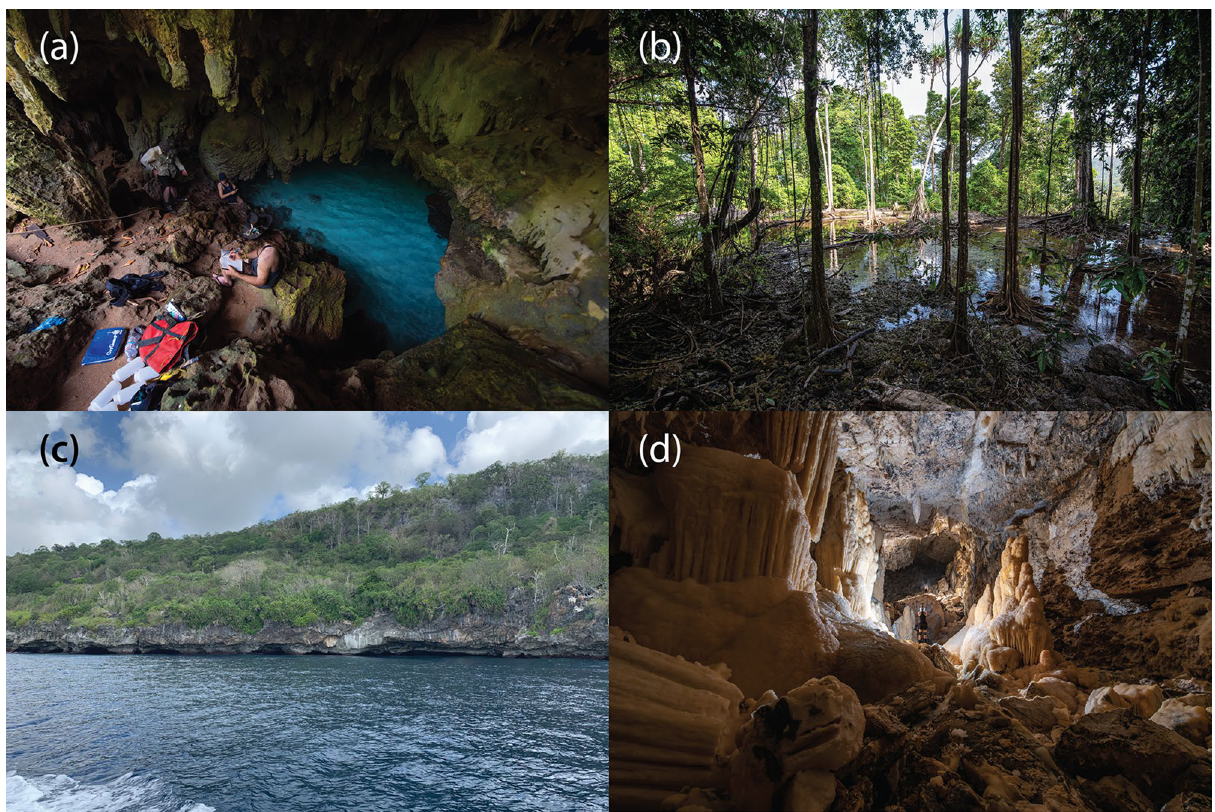
Figure 2. Imagery from eDNA sampling localities across Christmas Island. ( a ) Water and sediment sampling in The Grotto cave site. ( b ) The Dales wetland area where Hugh Dales Waterfall and CI-079 spring sites were sampled. The ( c ) ocean entrance and ( d ) a chamber passage through the extensive Lost Lake Cave system. Photos: Danny Wilkinson and Weidi Koh